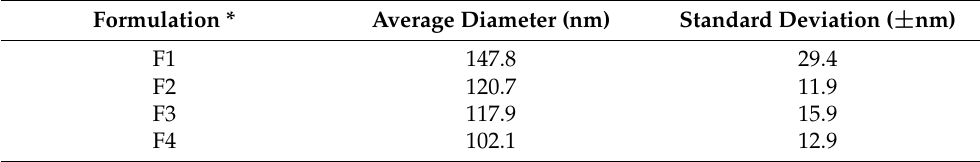
Figure 5. SEM images of electrospun CS/PVA/ox-CNO composite nanofibrous membranes. Formulations: ( F1 ) (CS:PVA:ox- CNO 8:92:0); ( F2 ) (CS:PVA:ox-CNO 8:91:1); ( F3 ) (CS:PVA:ox-CNO 3.5:95.5:1); ( F4 ) (CS:PVA:ox-CNO 5.4:92.6:2). For all the experiments, the voltage used was 20 kV, and its images at 5000 × . Table 2. Average diameters of the nanofibers CS/PVA/ox-CNO from the SEM